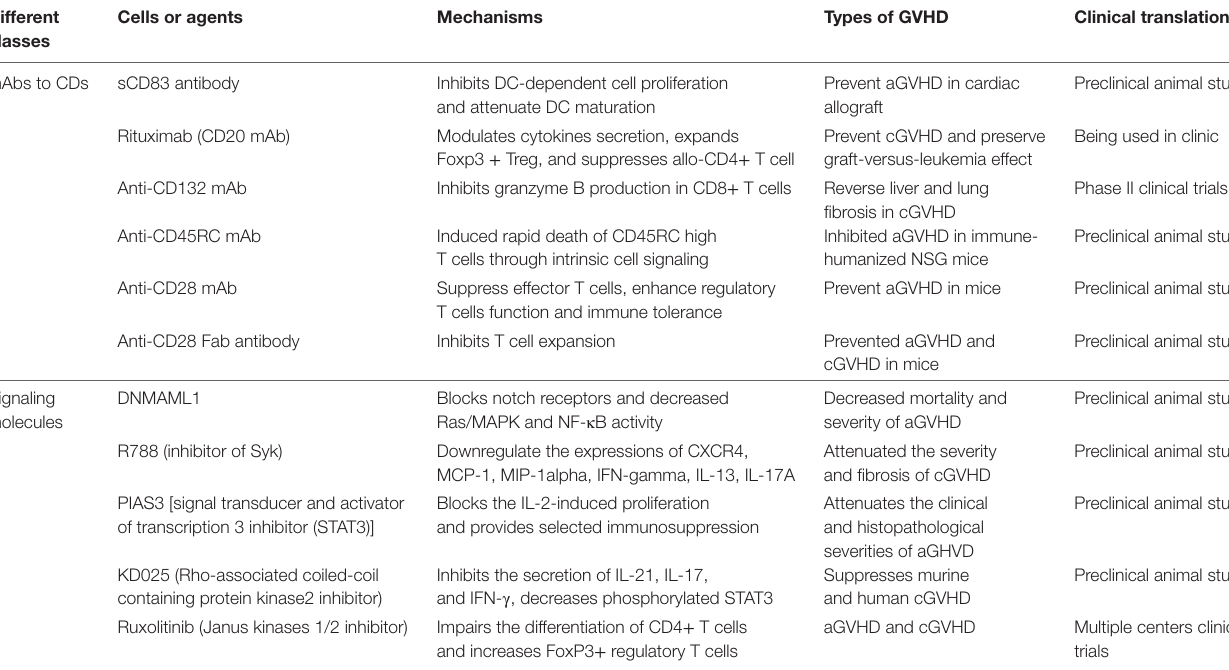
TAble 2 | Monoclonal antibodies (mAbs) to CDs and signaling molecules for the treatment of graft-versus-host disease (GVHD). Different